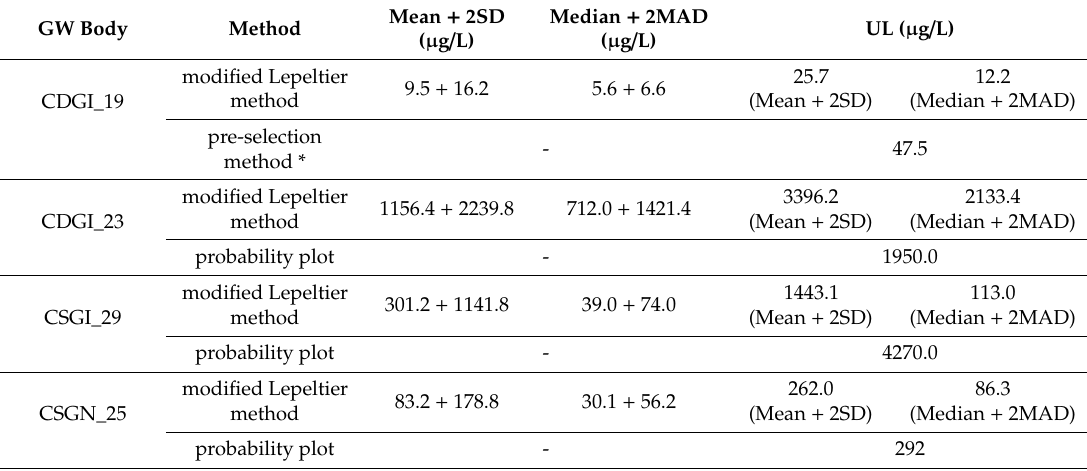
Table 5. Estimated Mean + 2SD and Median + 2MAD ranges (for modified Lepeltier method) and the upper limits of ranges of ambient background concentrations (UL) of iron (Fe) obtained by selected methods. EU Drinking Water Standard for Fe is 200 µ g / L.